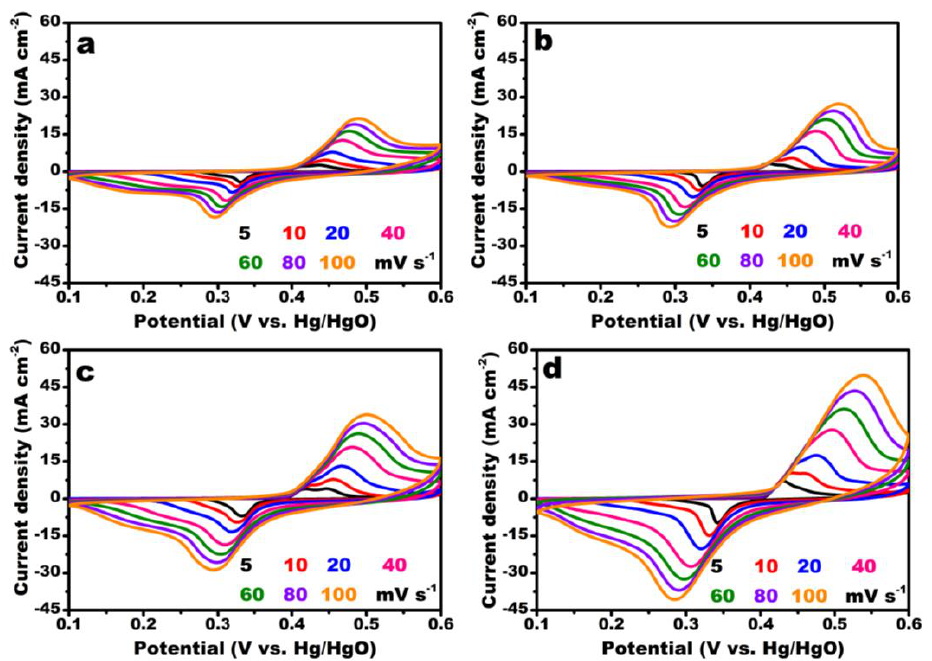
Figure 5. CV curves of the electrocatalysts in 1.0 M KOH at various scan rates for ( a ) CeO 2 , ( b ) CeO 2 – GO-1, ( c ) CeO 2 –GO-2, and ( d ) CeO 2 –GO-3.